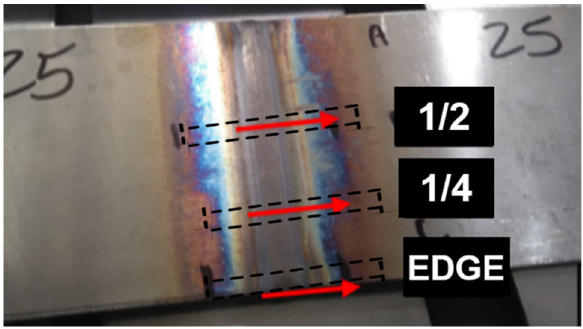
Figure 1. Indication of the cut regions in the welded sheet.